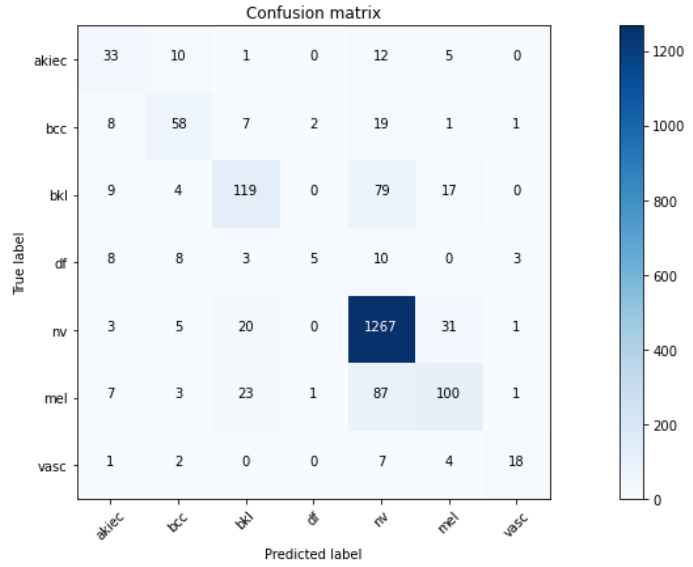
Figure 2. Classification result (confusion matrix) of the test set on the trained CNN